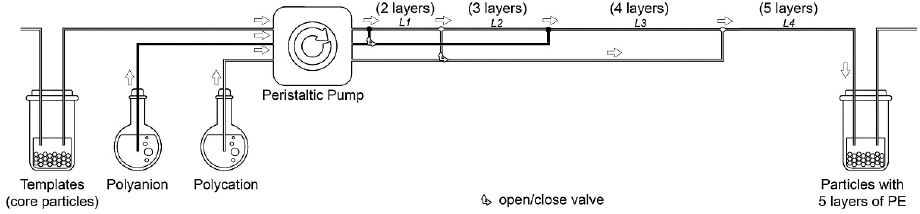
Figure 4. Sketch representing the experimental approach for the assembly process of LbL PEMUCS using a tubular reactor. Reprinted from Elizarova et al. [80], Copyright (2016), with permission from Elsevier.